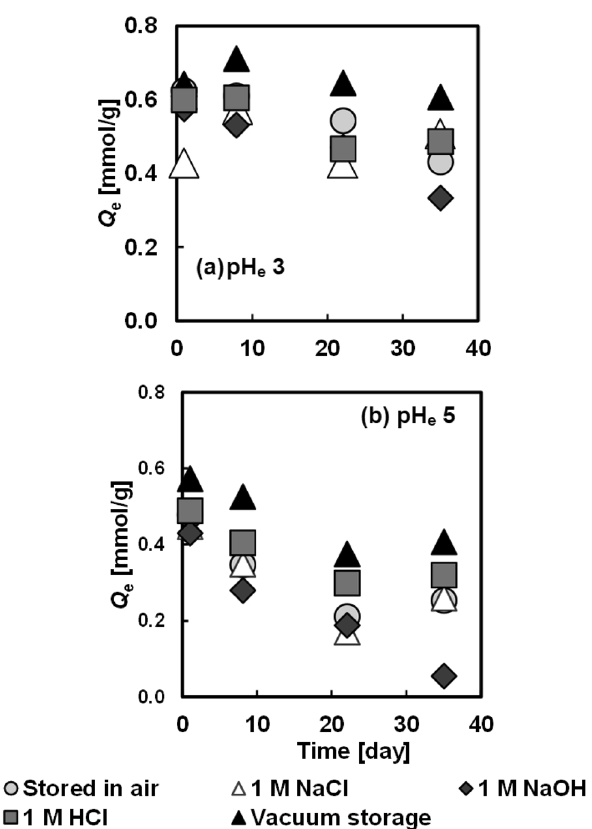
Fig. 3 Influence of storage conditions on the amount of NO 3− adsorption a at pH 3 and b at pH 5 e e